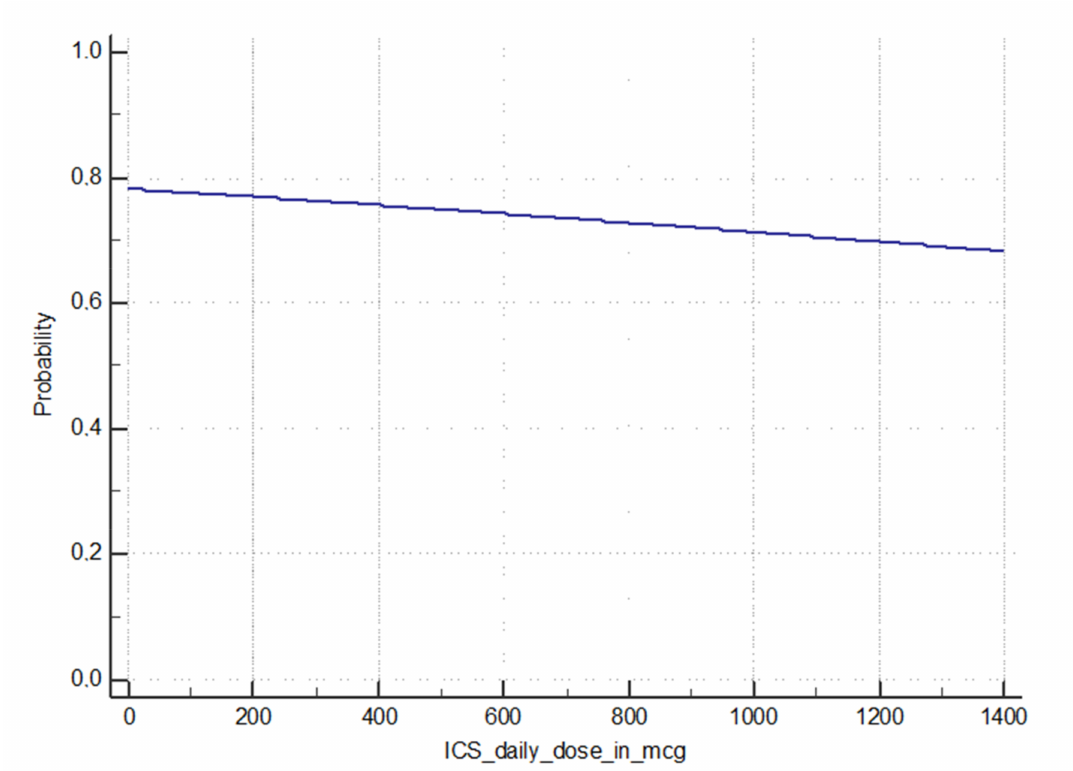
Figure 1. Logistic regression model—probability of hypertension in asthmatics with increasing daily intake of inhaled corticosteroid